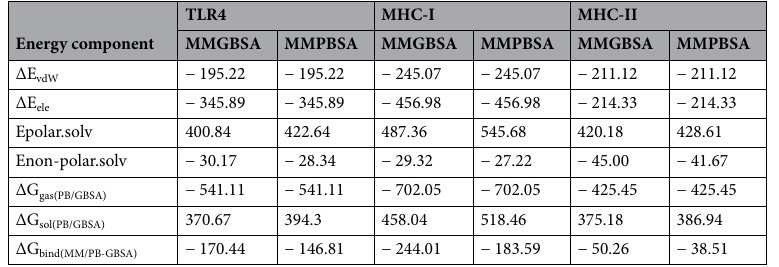
Table 4. Different energy components estimated in MMGBSA and MMPBSA for vaccine-receptor(s) complexes.